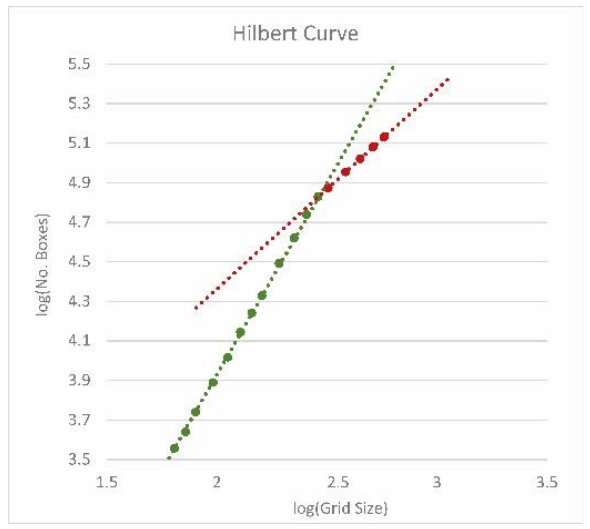
Figure 6. Hilbert Curve, measurement with 7 iterations showing flattening of the data curve.